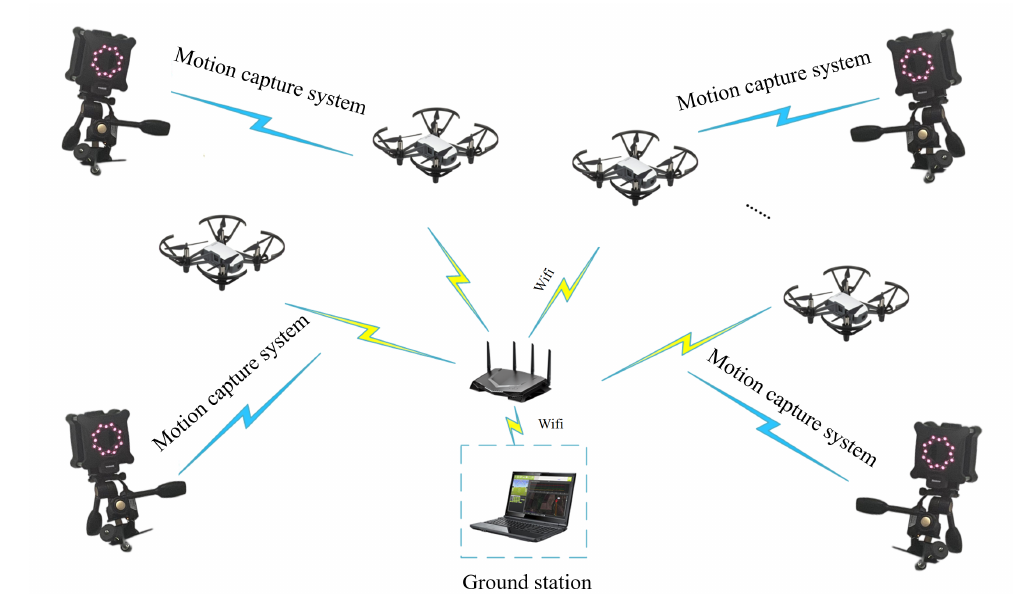
Figure 8. Hardware architecture of the experiment platform.